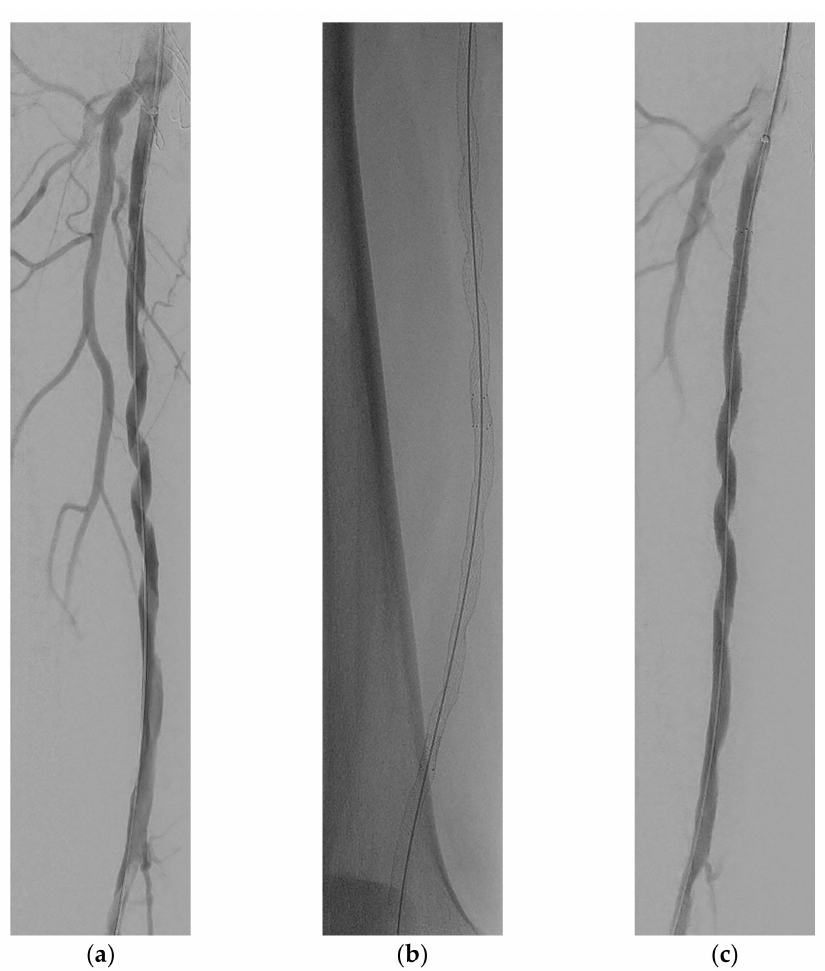
Figure 3. Overview of post percutaneous transluminal angioplasty (PTA) balloon dilatation DSA ( a ) and self-expandable (SE) stent placements result ( b ) and completion DSA ( c ). All three images show a similar corkscrew shape as the FORS enabled guidewire showed during recanalization of occluded SFA (Figure